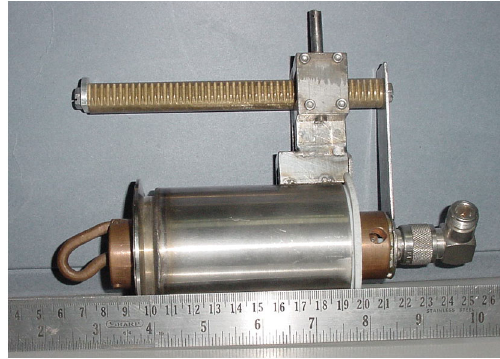
FIG. 11. (Color) The new power coupler.